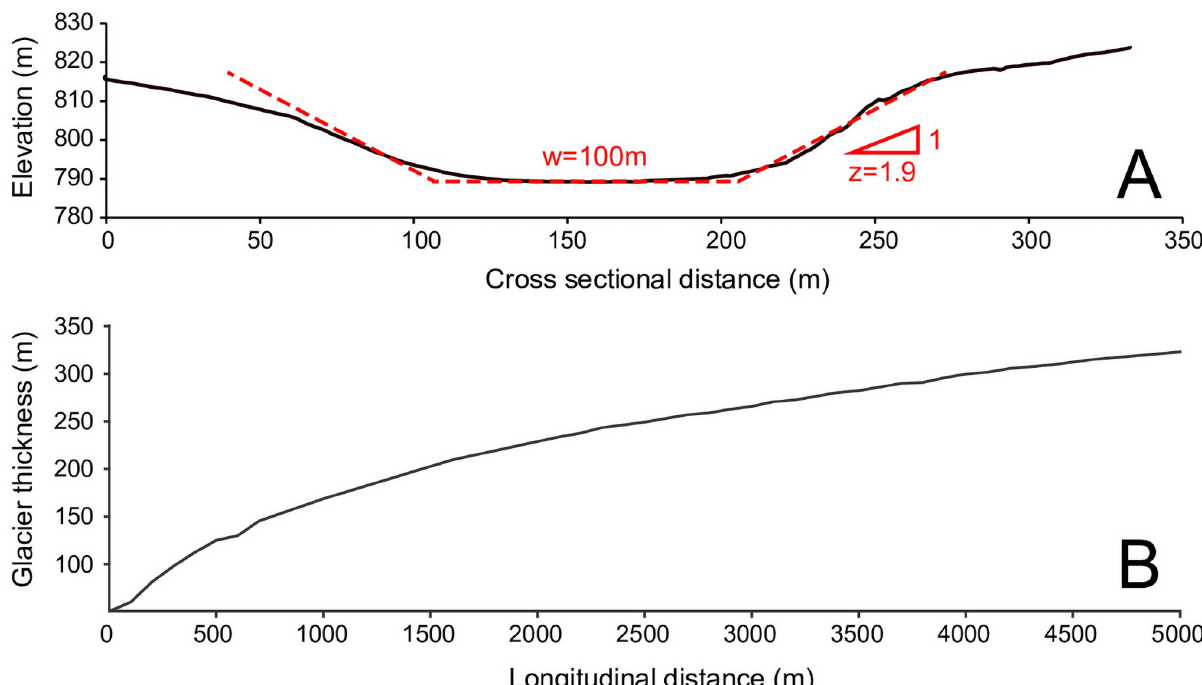
Fig 2. a) Typical cross section in the Labyrinth, Antarctica, derived from the LiDAR survey (black line) and the trapezoidal cross section adopted in the model (dotted red lines). The location of the cross section is indicated in red in Fig 1; b) glacier thickness profile reconstructed by Hall and Denton (2005) in the eastern Wright Valley,